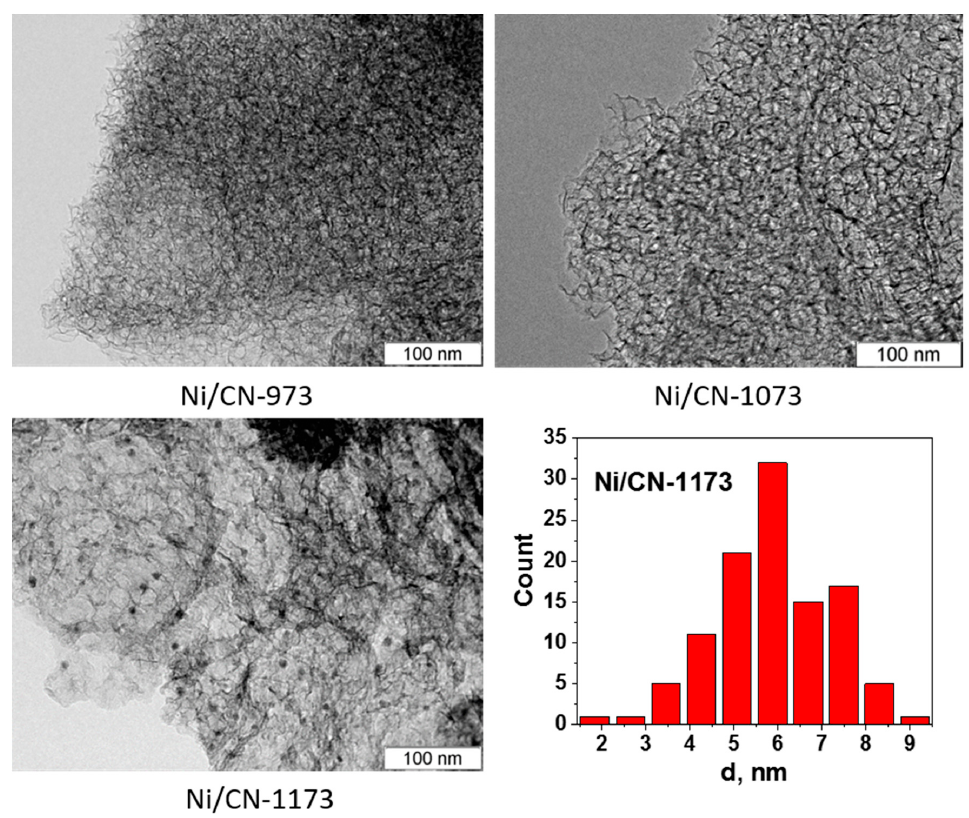
Figure 3. TEM images of the Ni catalysts, which were produced using nitrogen-doped porous carbon materials synthesized at 973 K (Ni / CN-973), 1073 K (Ni / CN-1073) and 1173 K (Ni / CN-1173), after the reaction and Ni particle size distribution for Ni /